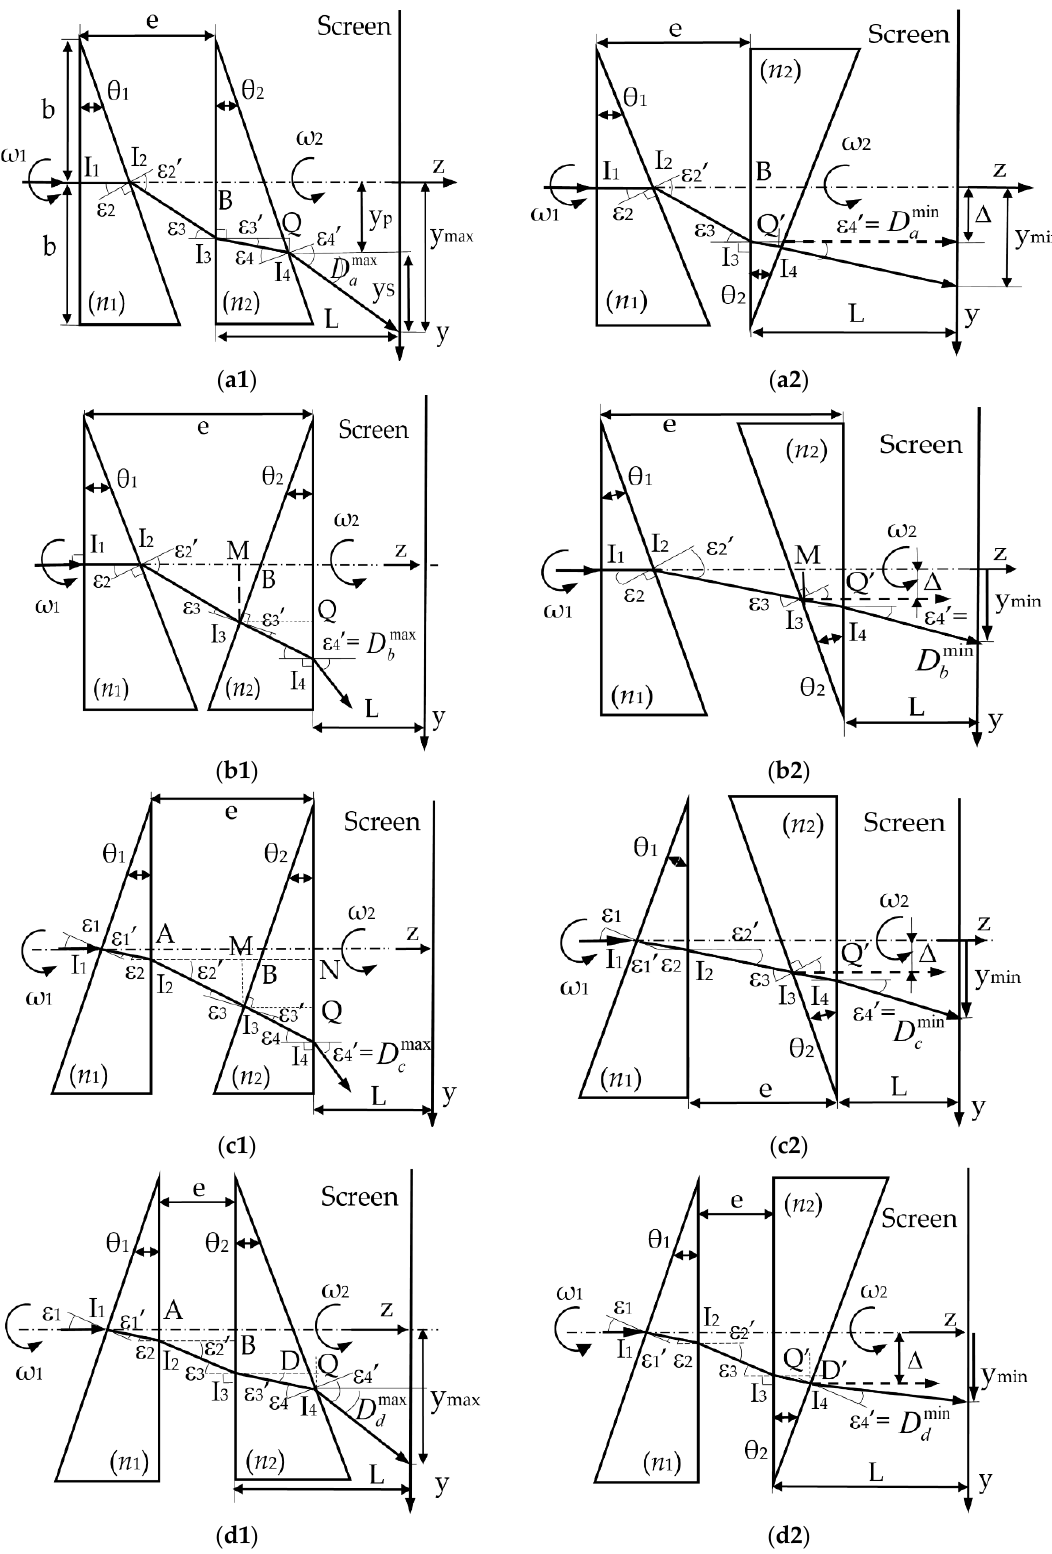
Figure 2. The four possible configurations of a laser scanner with a pair of rotational Risley prisms: ( a ) ab-ab ; ( b ) ab-ba ; ( c ) ba-ba ; ( d ) ba-ab . Notations: ‘ a ’ denotes a diopter perpendicular to the optical axis (O.A.) and ‘ b ’ a tilted one. Each configuration is shown in two extreme characteristic positions of the device, namely with a relative rotation angle between two prisms φ = 0 (column 1 ) and φ = π (rad) (column 2 ).